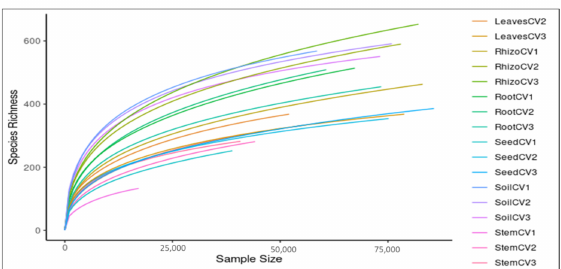
Figure 1. Rarefraction analysis of fungal community richness estimates based on sequences that passed the Phred quality score of 25. CV1, CV2, and CV3 correspond to sorghum cultivars PAN8076W, PAN8816 and NS5511, respectively.